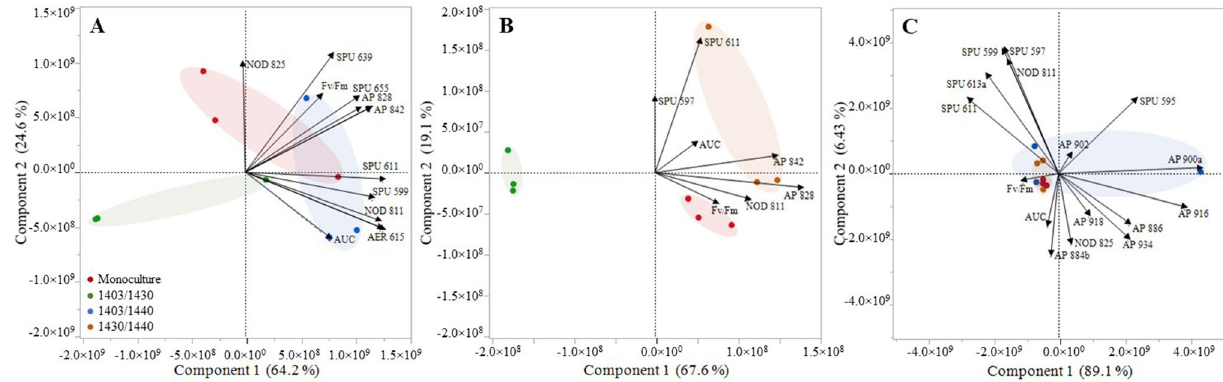
Figure 3. Principal Component Analysis (PCA plots showing Component 1 and Component 2 with the variance explained) of the cell-bound NRP levels in N. spumigena ; ( A ), 1403; ( B ), 1430; and ( C ), 1440. Treatments: monoculture (red) and co-cultures: 1403/1430 (green), 1403/1440 (blue) and 1430/1440 (orange); NRP classes are denoted as: SPU, spumigins; NOD, nodularins; AER, aeruginosins and AP,